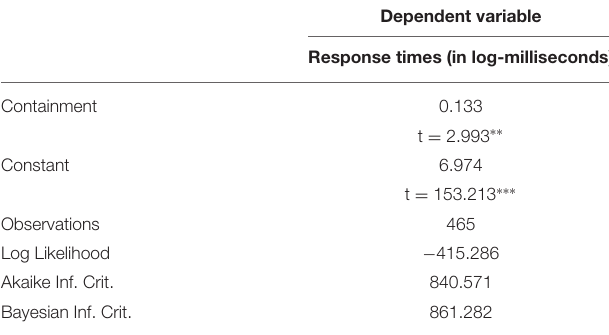
TABLE 13 | Regression analysis of response-times in Experiment